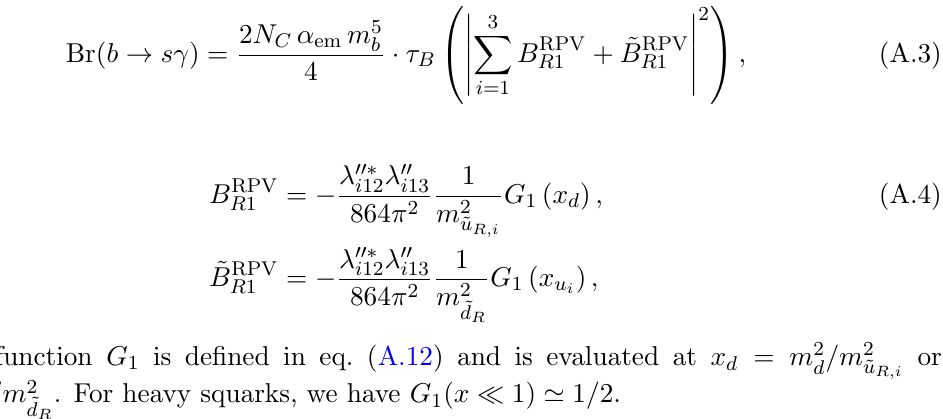
branching ratio